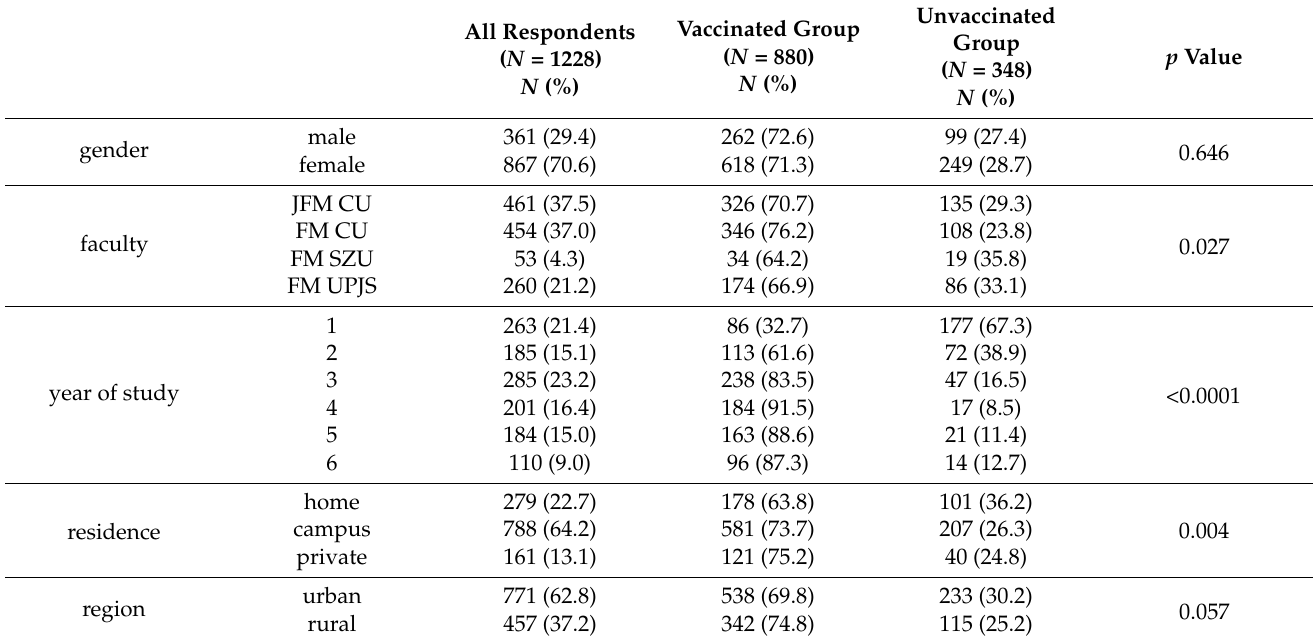
Table 1. Demographic factors associated with vaccination status among medical students in